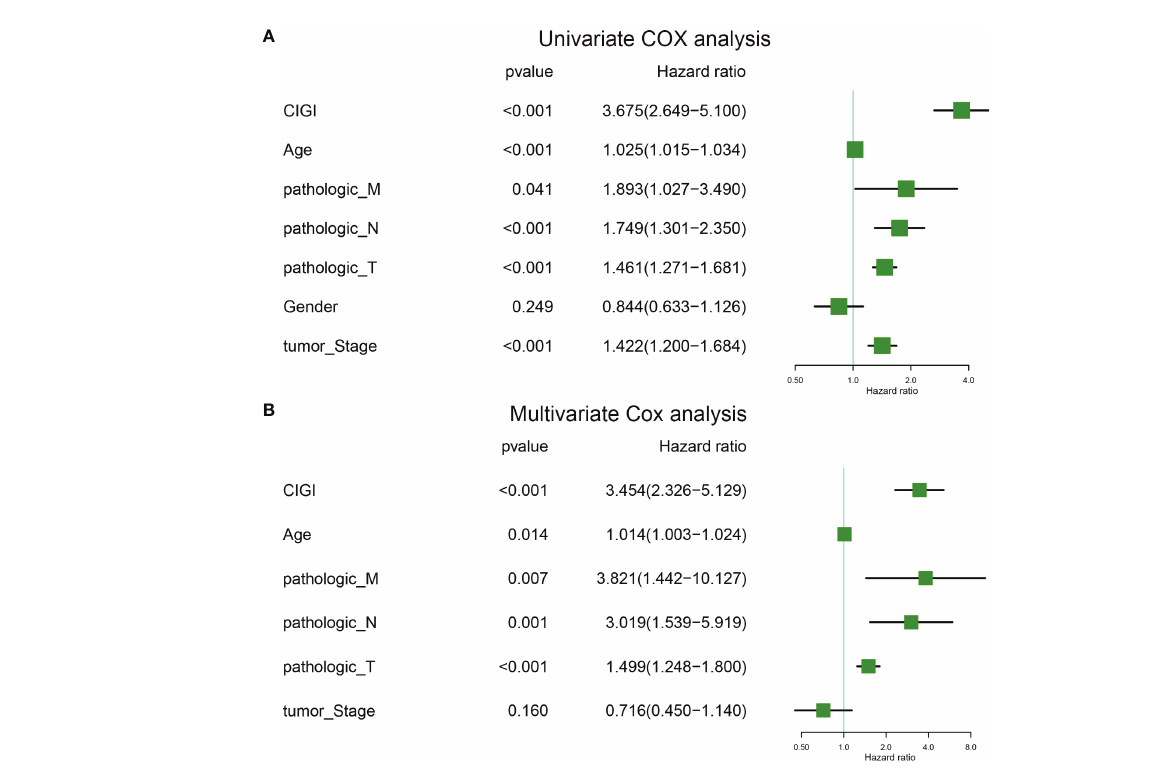
FIGURE 5 | Univariate and multivariate cox analysis of CIGI. (A) Univariate Cox analyses of OS in the TCGA dataset. (B) Multivariate Cox analyses of OS in the TCGA